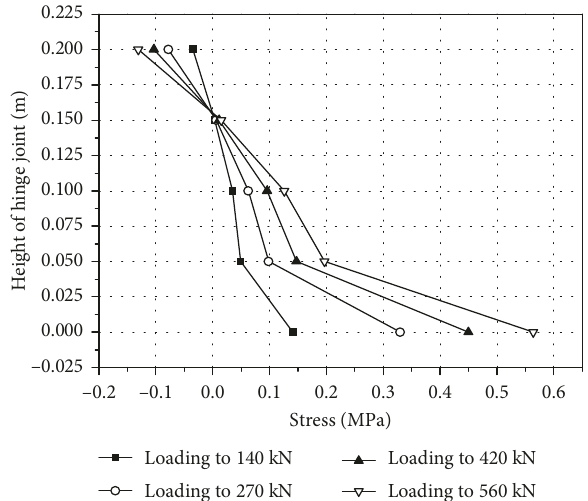
Figure 15: Transverse strain curves along the section height of the hinge